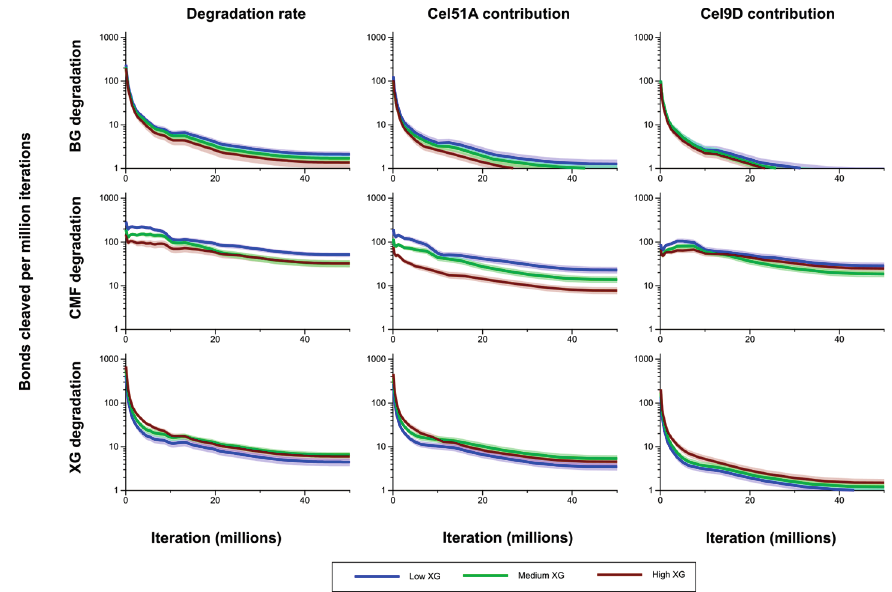
Figure 7. Bond cleavage rate in the (1,3;1,4)- β -glucans (BG), CMFs and XG for the model Low, Medium and High XG walls, and the contributions of Cel51A and Cel9D to this degradation. The shaded region represents a 95% Least Significant Interval so that any two of the three curves are significantly different at the 5% level where their bands do not overlap. The solid line in the middle indicates the mean